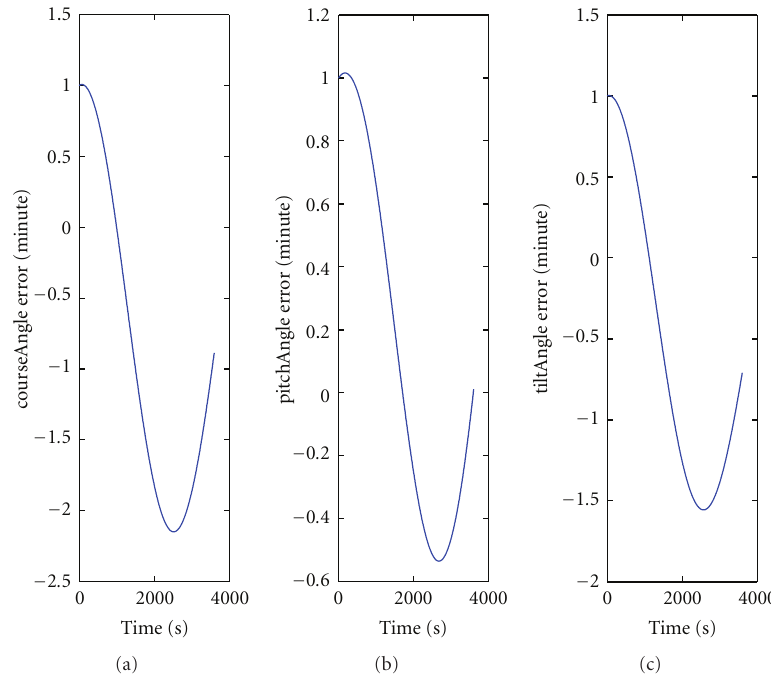
Figure 10: Angle error of static